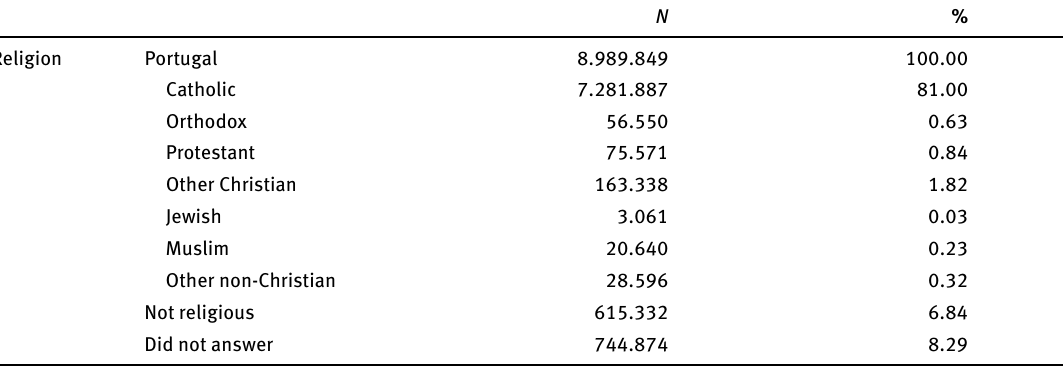
Table reprinted and adapted from INE (2012, p. 530), based on 2011